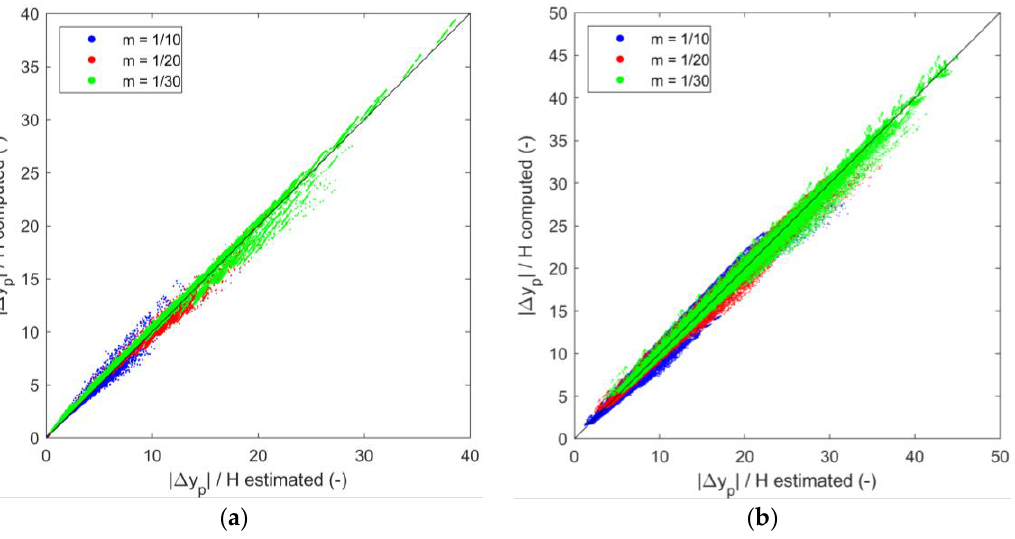
Figure 11. Comparison between | Δ y p |/H 0 computed by the model and | Δ y p |/H 0 computed with best-fit equations in presence of emerged breakwaters (panel ( a ), Equation (20), r 2 = 0.997) and submerged breakwaters (panel ( b ), Equation (24), r 2 = 0.992).